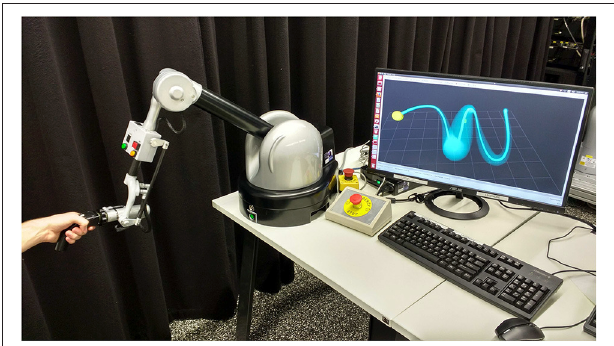
FIGURE 1 | Human manipulating a haptic device, the Haption Virtuose 6D. In our experiments, the haptic device assists the movements of the human by providing force feedback which is inversely proportional to the standard deviation of a distribution over trajectories (example is shown on the computer